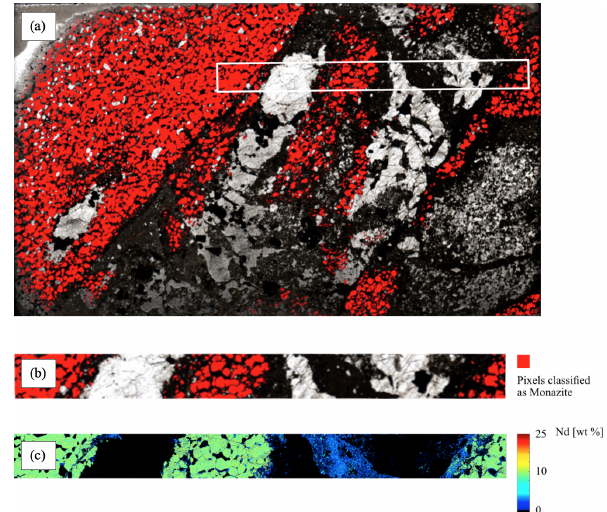
Figure 5. (a) True color RGB (R: 640.27nm; G: 549.36nm; B: 458.44nm) with monazite (Nd) map classification overlaid. Red pixels are classified as monazite (Nd). The other pixels are dis- played according to their true color information (R: 640.27nm; G: 549.36nm; B: 458.44nm). Area shown in (b) and (c) is indicated by a white rectangle. (b) Close up of (a) (indicated region). (c) Result of Nd 2 O 3 mapping by electron microprobe across the profile re- gion indicated in (a) (white rectangle), showing the highest Nd 2 O 3 concentrations within monazites (green) and lower concentrations within allanites